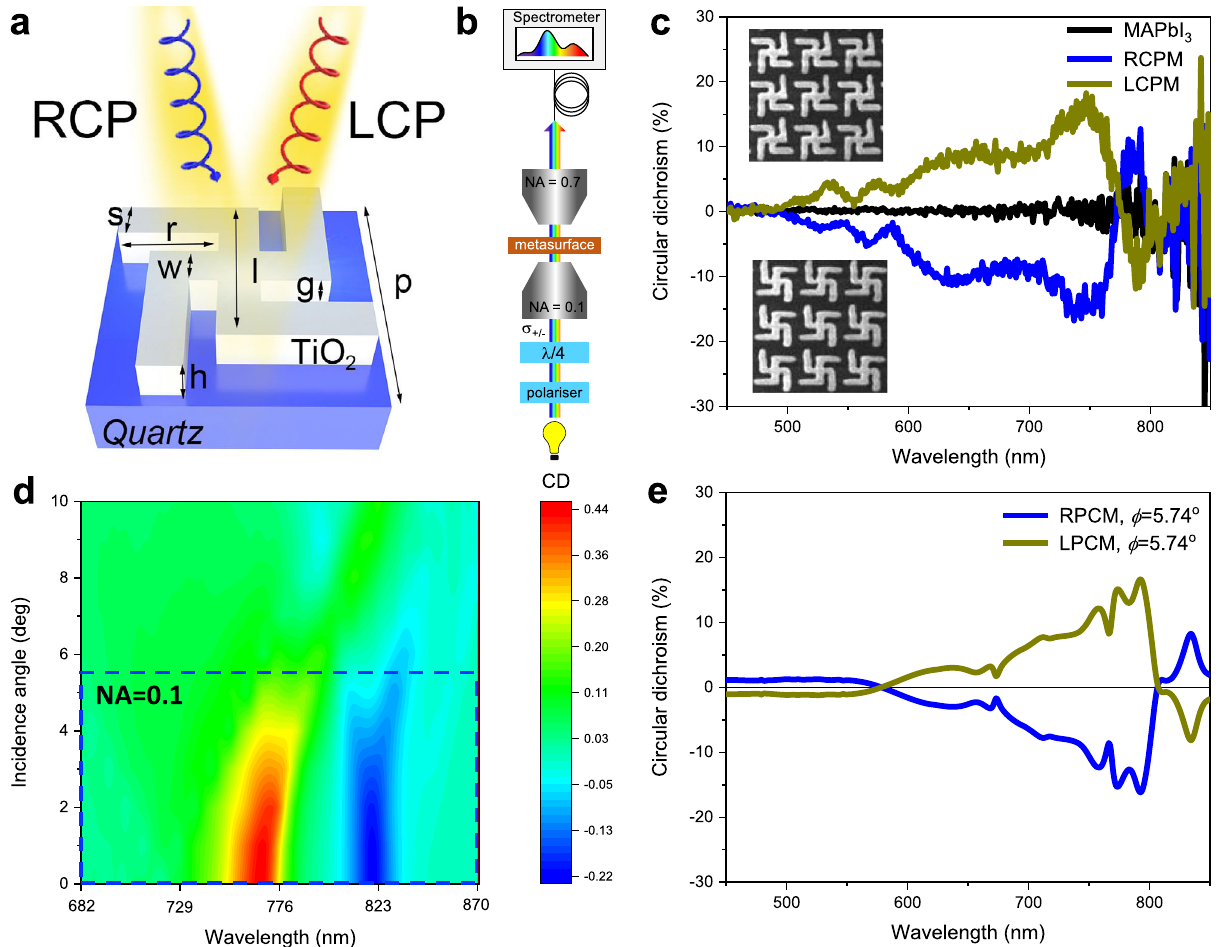
Fig. 2 Giant circular dichroism of perovskite chiral metasurfaces. a Schematic of a left-handed perovskite chiral metamolecule on quartz substrate ( s = 120 nm, r = 305 nm, w = 120 nm, l = 500 nm, g = 70 nm, h = 315 nm, p = 730 nm). b Micro-spectrometer setup for the measurement of circular dichroism on small area metasurfaces. c Experimental circular dichroism of unpatterned MAPbI 3 fi lm, right- and left-handed perovskite chiral metasurfaces (RPCM and LPCM), illuminated over a solid angle with NA of 0.1. The insets show scanning electron microscope images of 3×3 unit cells of LPCM and RPCM. d Color map of simulated circular dichroism of the LPCM as a function of wavelength and incidence angle ϕ . e Spectra of the simulated circular dichroism of the RPCM and LPCM for an incidence angle ϕ = 5.74 o